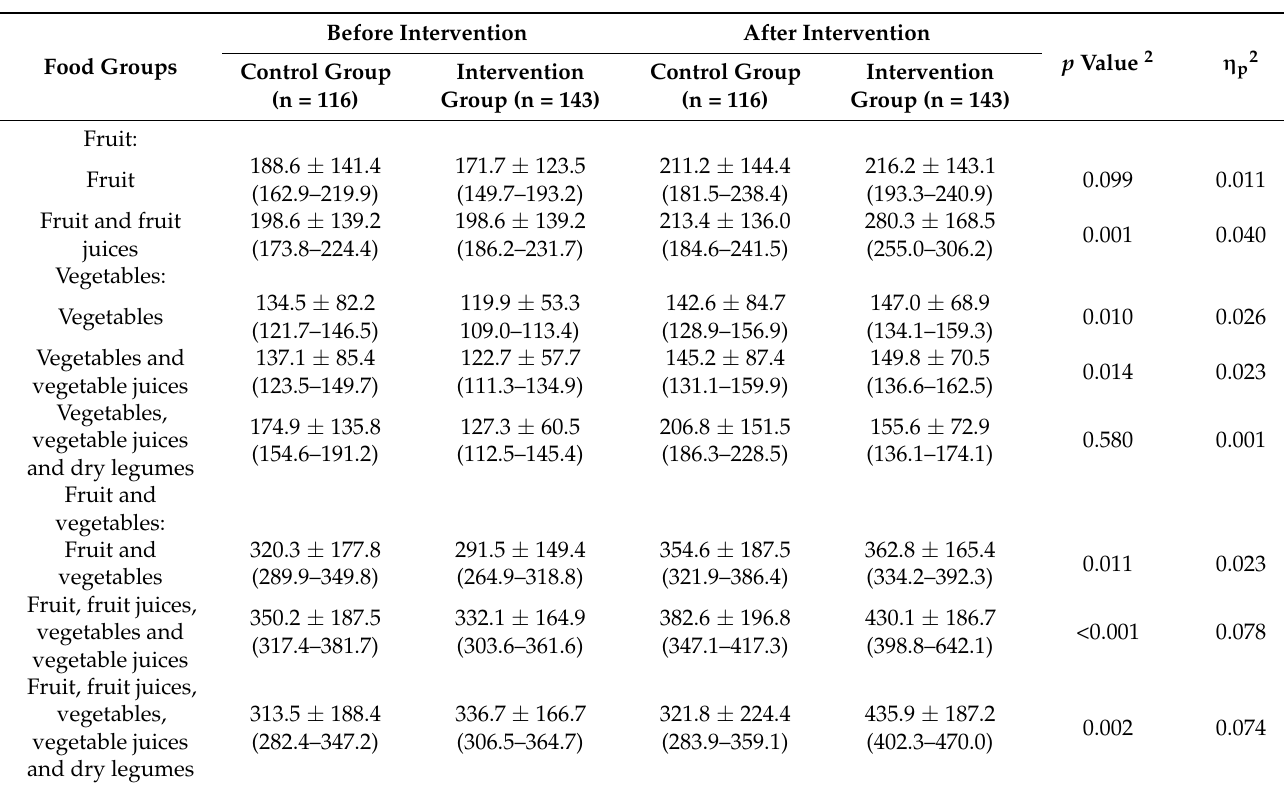
Table 3. Comparison of children’s fruit and vegetable intake between the control group and the intervention group before and after the intervention 1